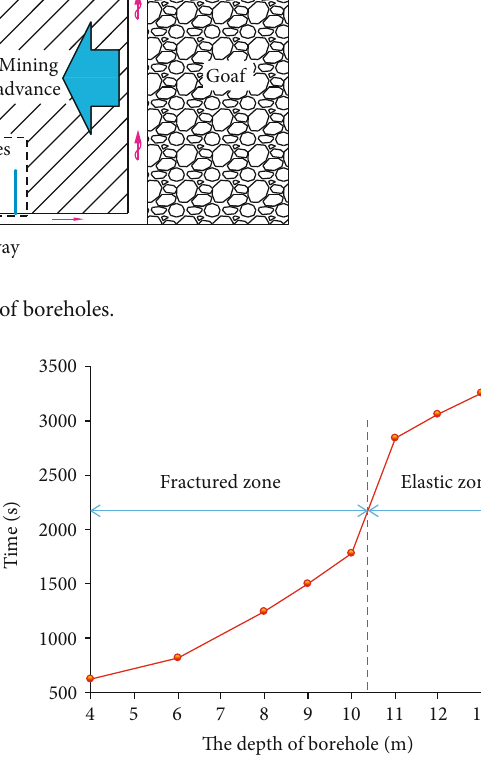
Figure 7: Time for gas pressure attenuation to 0.04MPa in boreholes at di ff erent